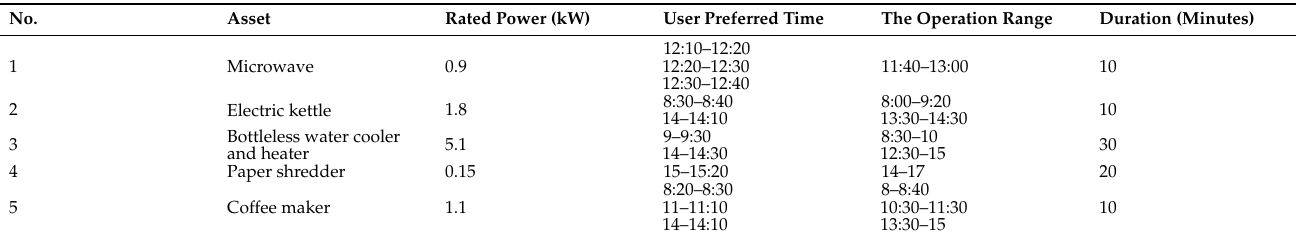
Table 2. Time-shiftable assets for an office